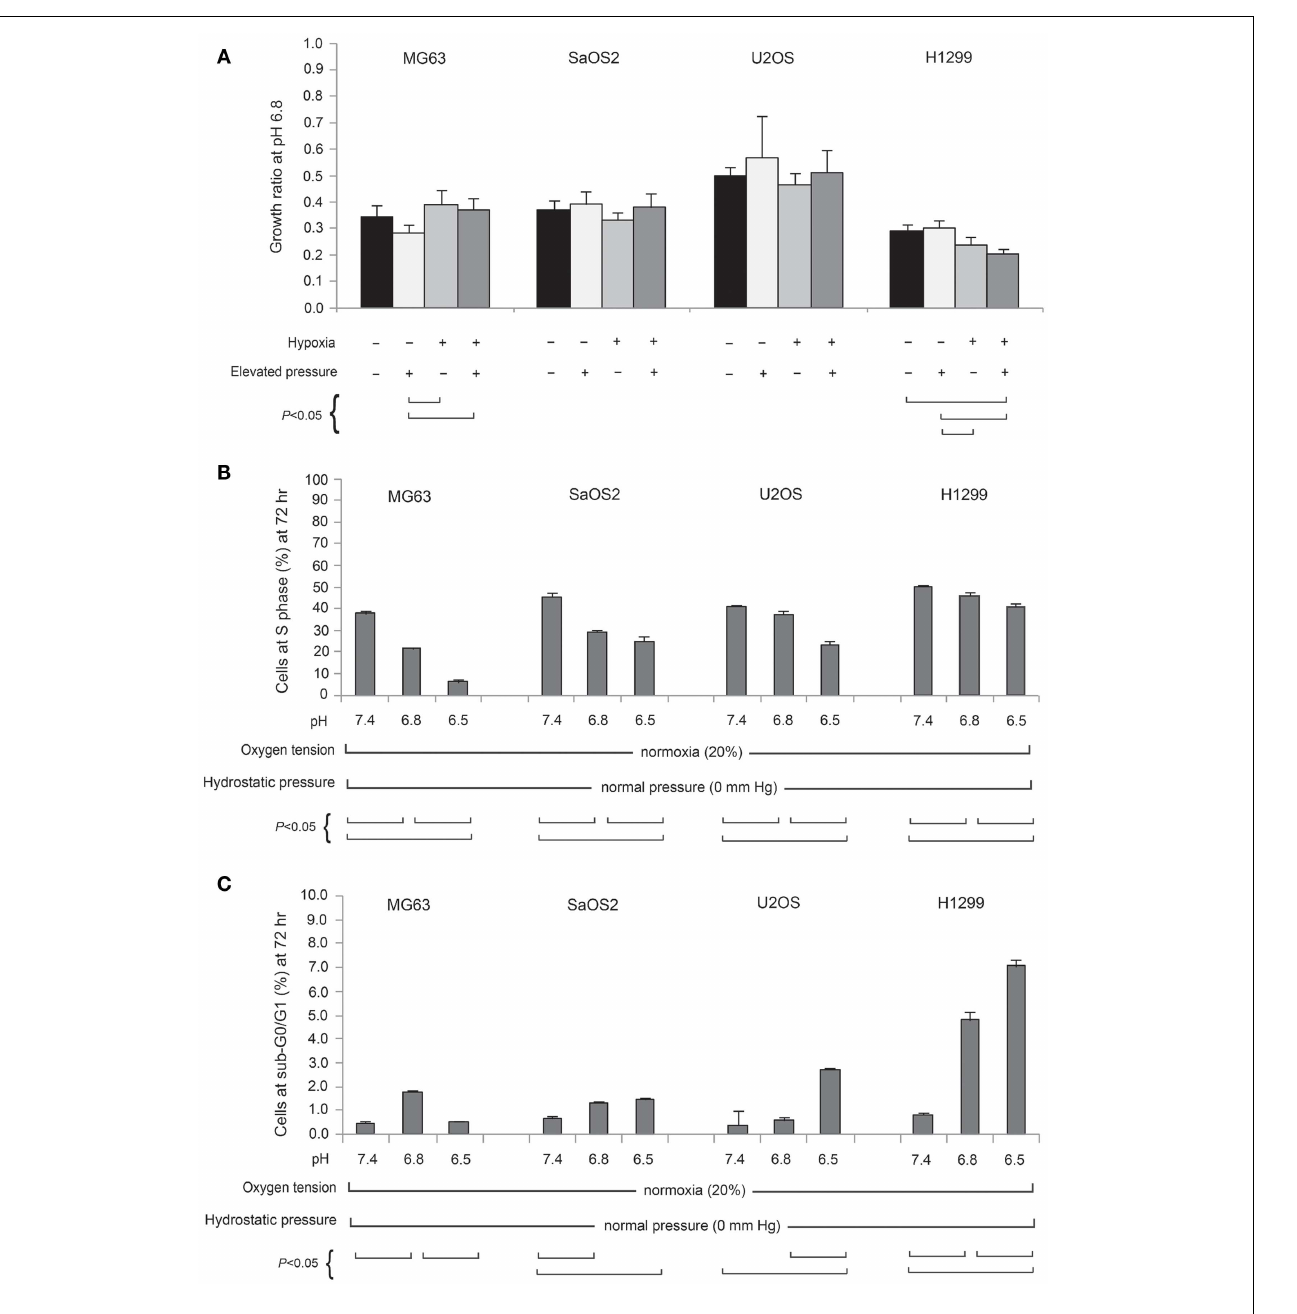
pH conditions ( Figure 3 ; dark bar). The actual expression of CA IX in OS cells was higher than in H1299 lung cancer cells ( Figure 3 ). Compared with typical cell culture conditions (pH 7.4, 20% oxygen,and 0 mmHg pressure,which we considered to be the “neutral” condition), the combinations of altered microenviron- mental conditions increased gene expression by the factors shown in the figure. Specifically, in MG63 cells, hypoxia elevated CA IX